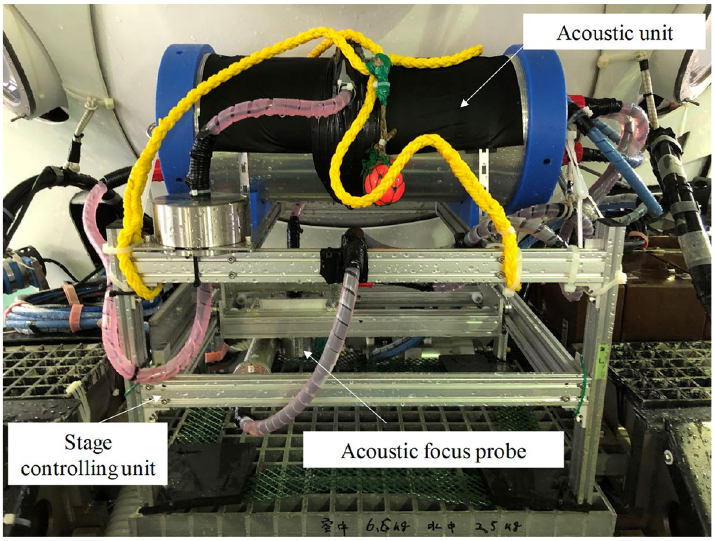
Figure 1. Deep-sea acoustic “coring” system (A-core 2000). The focused transducer is equipped on the pole extended form the 2D frame. It moves in horizontal directions and scans the sediment below.